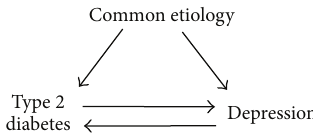
Figure 1: Possible directions of the association between type 2 diabetes and